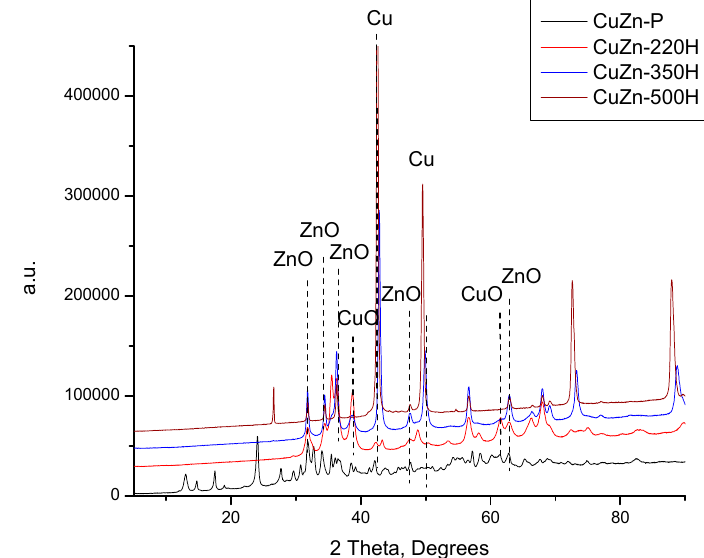
Figure 3. The XRD patterns of catalysts prepared by the treatment of the CuZn precursor in flowing hydrogen at 220, 350, and 500 °C.